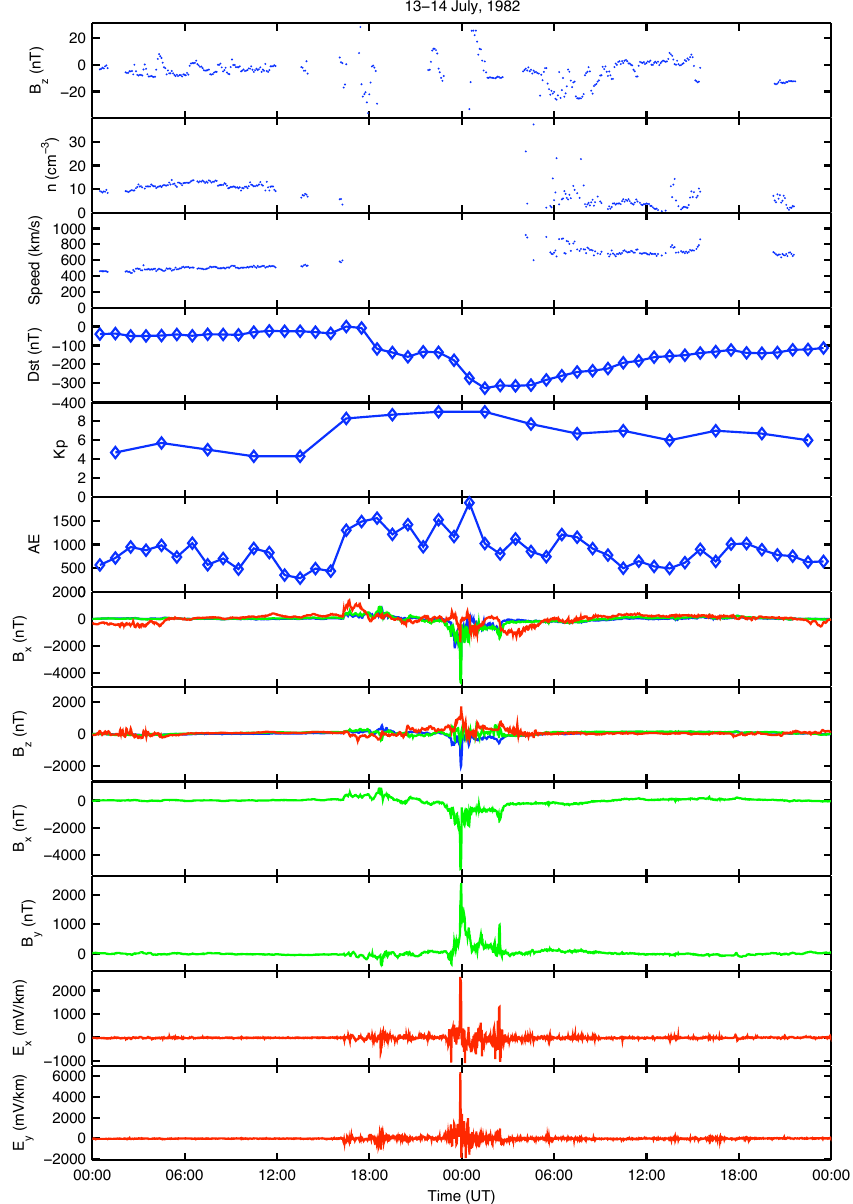
Fig. 4. Stack plot of IMP8 solar wind data, geomagnetic indices, geomagnetic data and geoelectric data for 13–14 July 1982. The IMP8 data, in the top three panels, include the solar wind magnetic field component B z , the solar wind density, and the speed. The following panels show the geomagnetic indices D st , K p and AE . Measured geomagnetic components, B x and B z , are shown for Brorfelde (blue), Lov¨o (green) and Sodankyl¨a (red). Interpolated geomagnetic north B x and east B y components are shown next. These data refer to the more northern red grid point in Fig. 1 (see additional details in the text). Below the geomagnetic data are the calculated geoelectric north E x and east E y components at the same